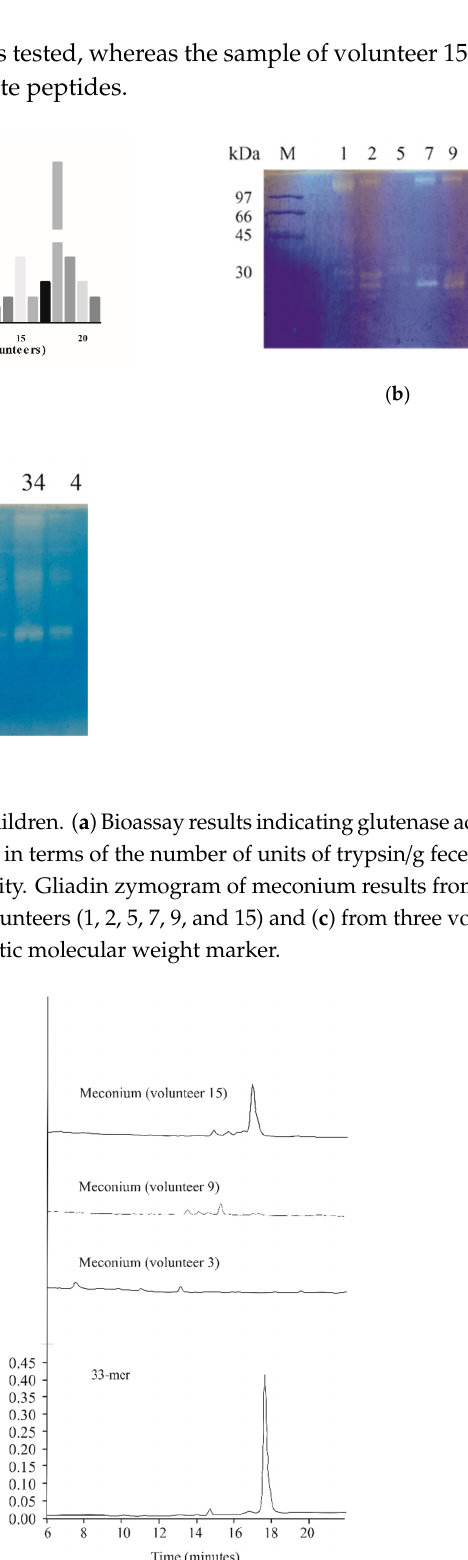
Figure 2. Meconium hydrolytic activity against 33-mer gliadin peptide. High-performance liquid chromatography (HPLC) chromatograms generated after incubating the 33-mer peptide for 60 min at 37 °C with desalted meconium protein extracts from newborn volunteers (3, 9, and 15) chosen as representative hydrolytic models. The bottom of the figure shows the chromatographic migration of the peptide.